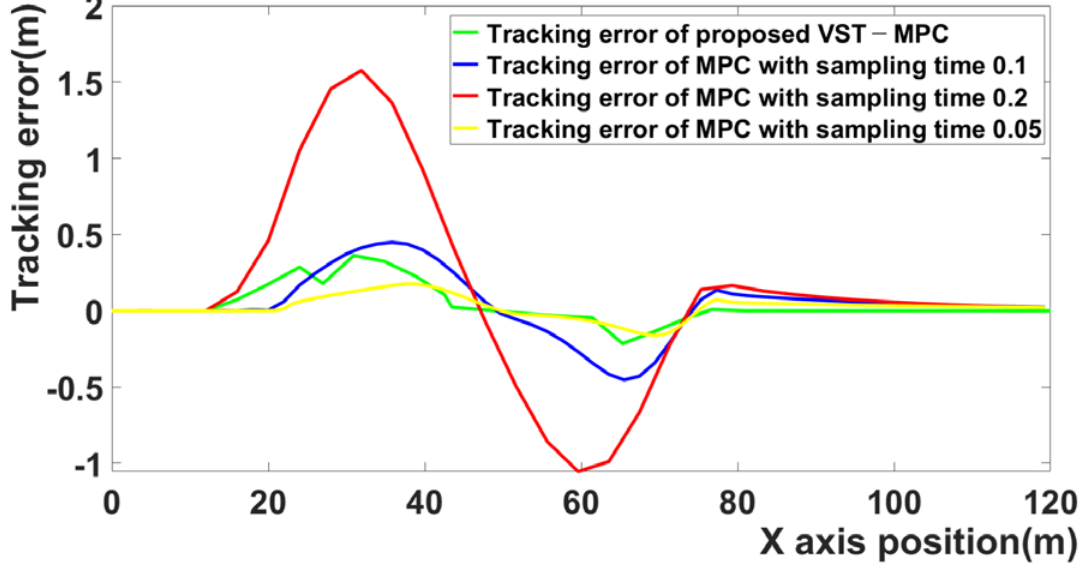
Figure 11. Comparison for tracking error of four MPC algorithms. Table 3. Average tracking error and entire computation time of four MPC algorithms.